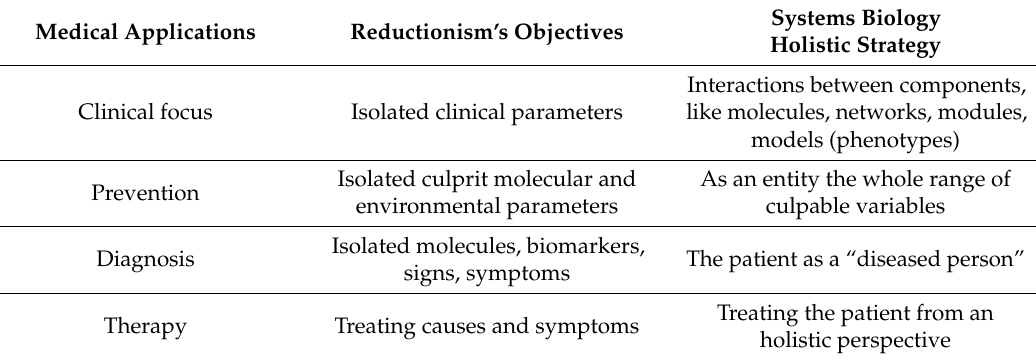
Clinical understanding of chronic cardiac diseases with reductionism and systems biology approach. Medical